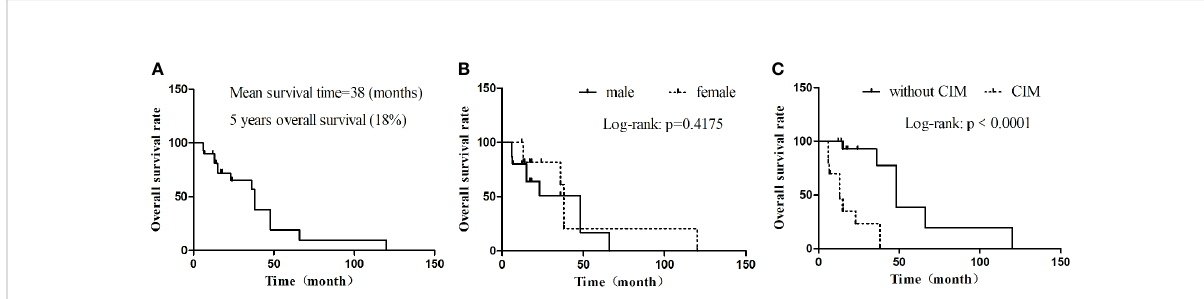
FIGURE 5 Kaplan – Meier OS. (A) OS in all cases; (B) OS by gender; (C) OS by whether there are cranial invasion or distant metastasis. CIM, cranial invasion or distant metastasis; MST, median survival time; OS, overall